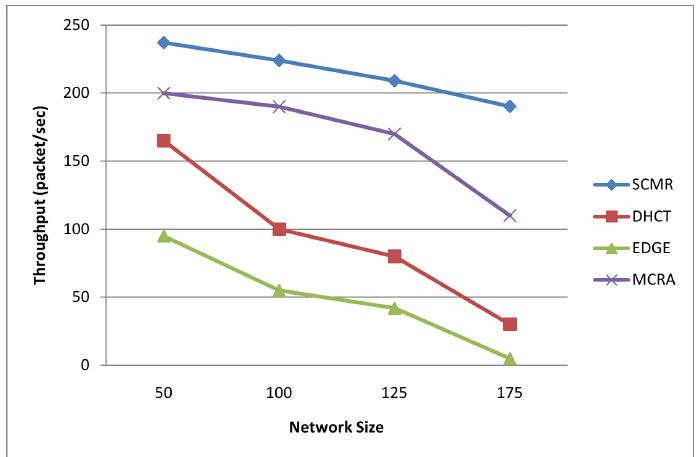
Figure 8. Throughput of Our Protocol Compared with Other Protocols.